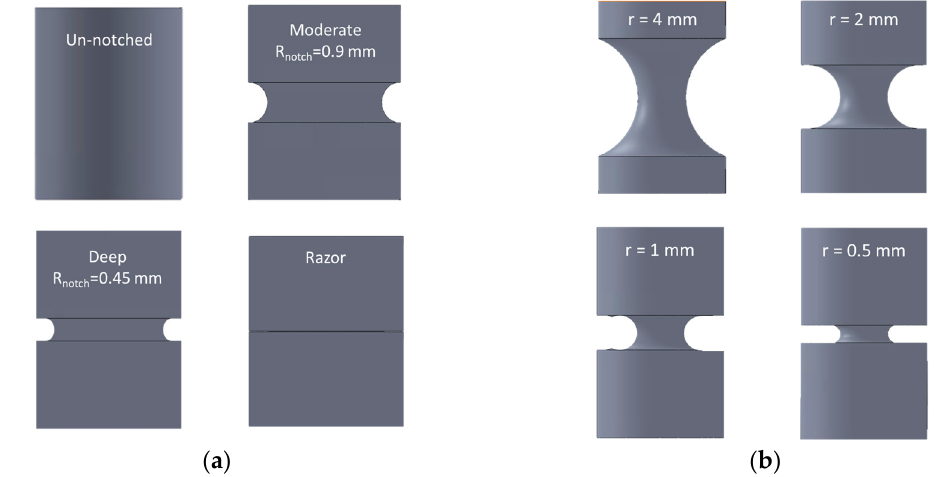
Figure 1. Schematic view of specimen geometries: ( a ) Geometries tested in Ref. [10]; ( b ) Geometries tested in Ref. [11].